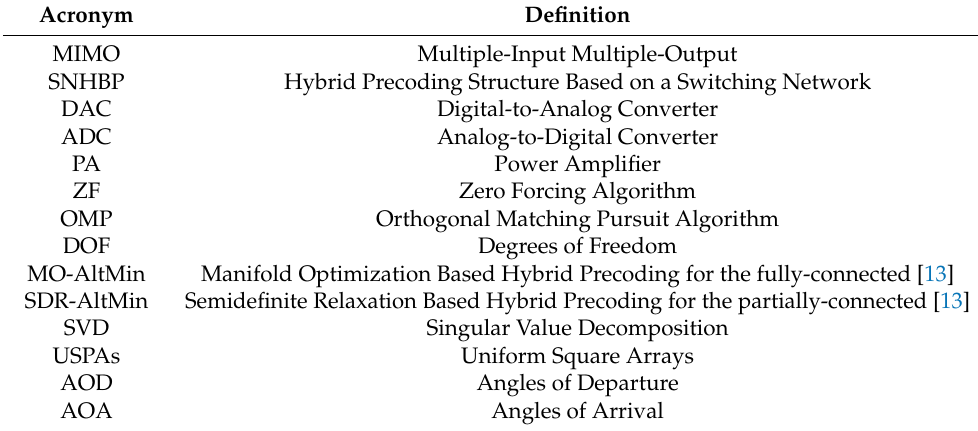
Table 1. Table of